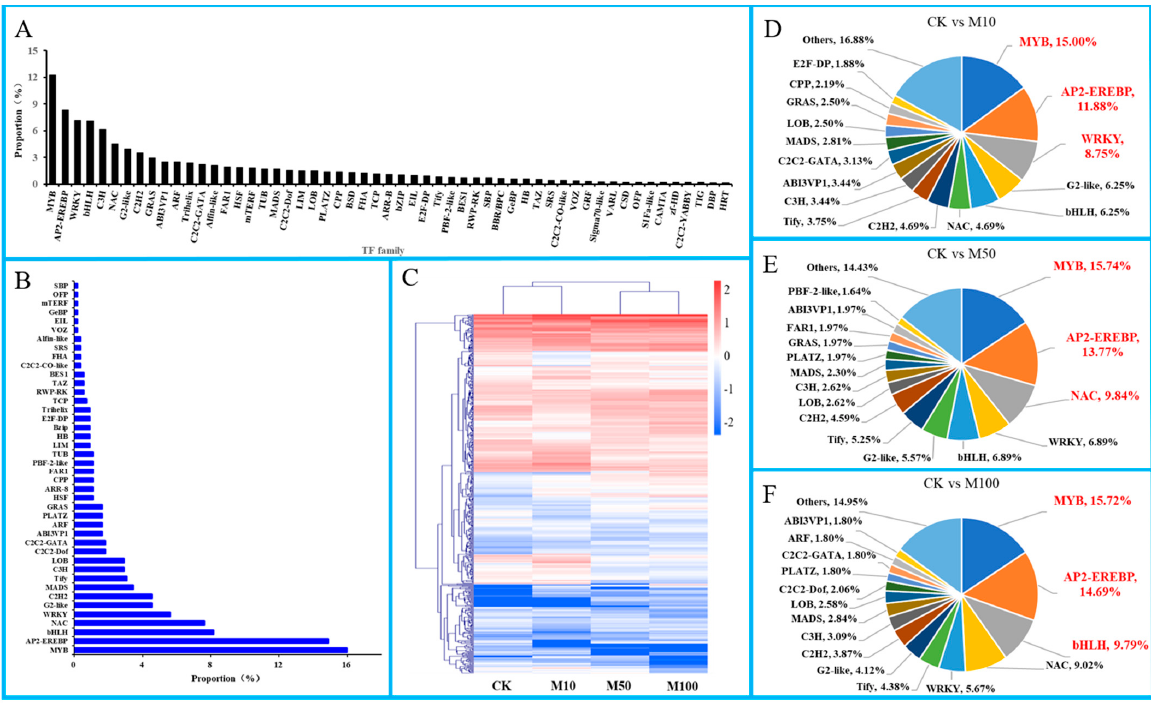
Figure 7. TFs in rosemary suspension cells under MeJA treatments. ( A ), classification statistics of TFs. ( B ), the Frequency distribution of differentially expressed TFs. ( C ), cluster analysis of expres- TFs. ( B ) the Frequency distribution of differentially expressed TFs. ( C ) cluster analysis of expression profiles of TFs. ( D ) statistic of differentially TFs in the comparisons of CKvsM10. ( E ) statistic of differentially expressed TFs in the comparisons of CKvsM50. ( F ) statistic of differentially expressed TFs in the comparisons of